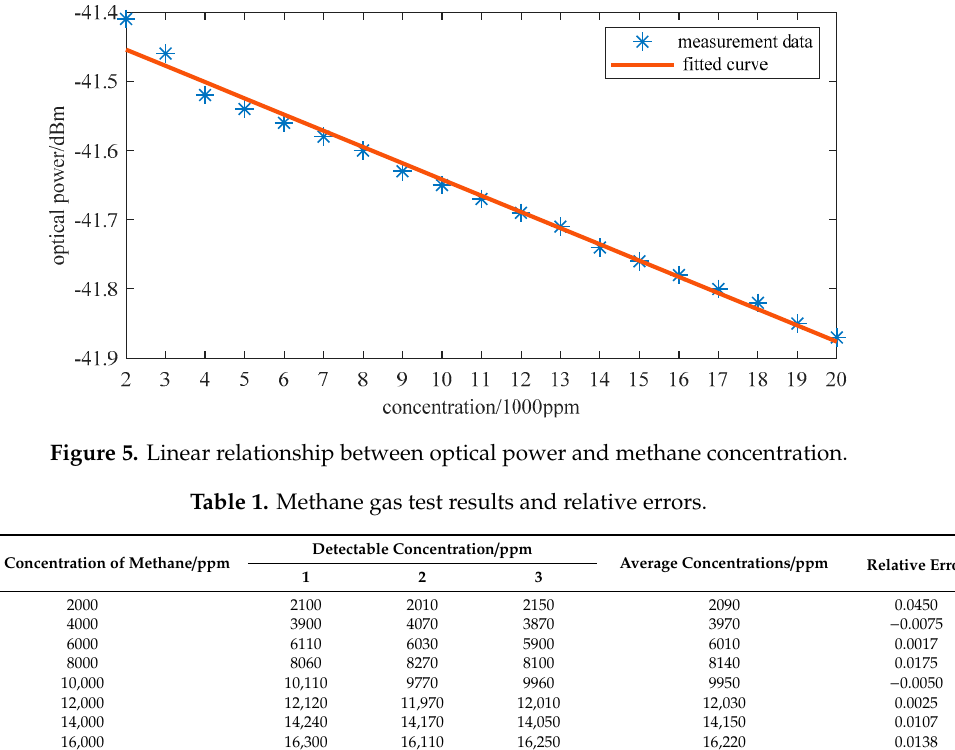
Figure 4. Spectra of four concentrations of methane gas.